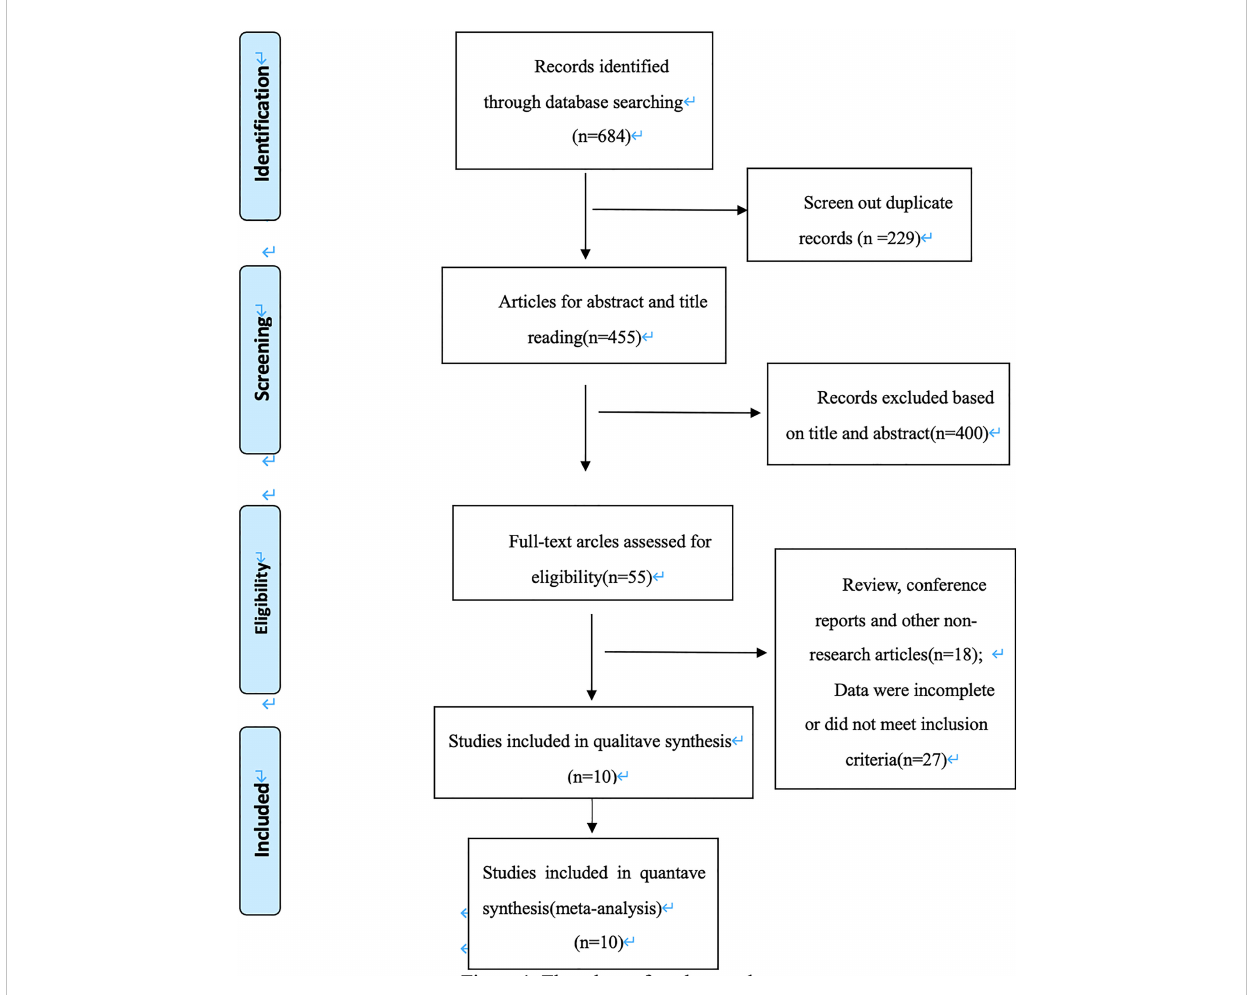
FIGURE 1 Flowchart of study